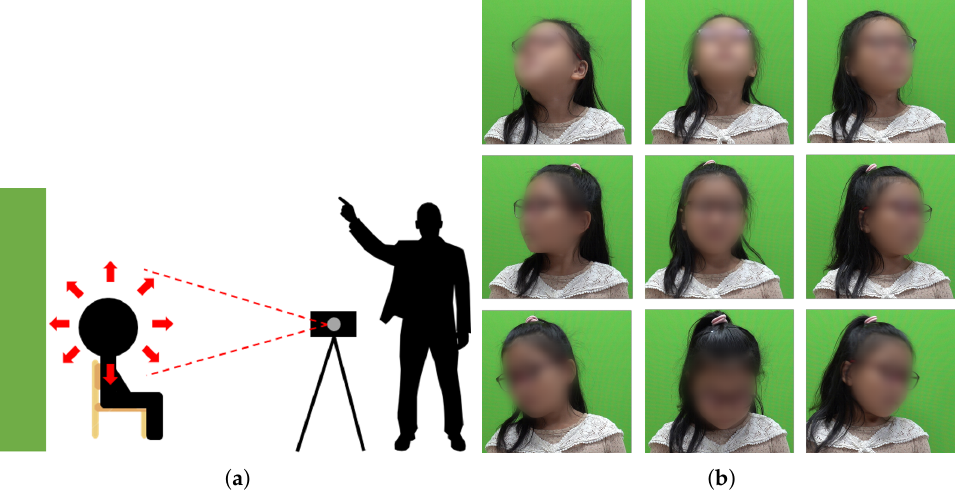
Figure 2. Face data collection for children aged 5 to 7: ( a ) camera position; ( b )